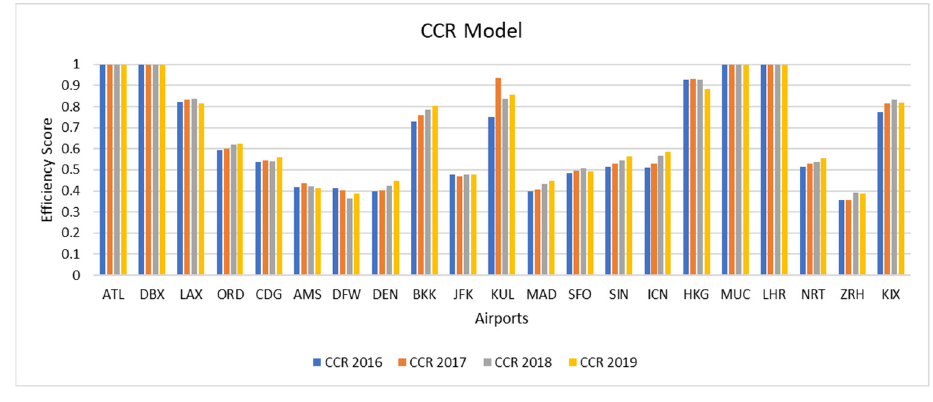
Mathematics 2022 , 10 , 551 Figure 3. Efficiency score of the CCR model. Figure 3. Efficiency score of the CCR model.